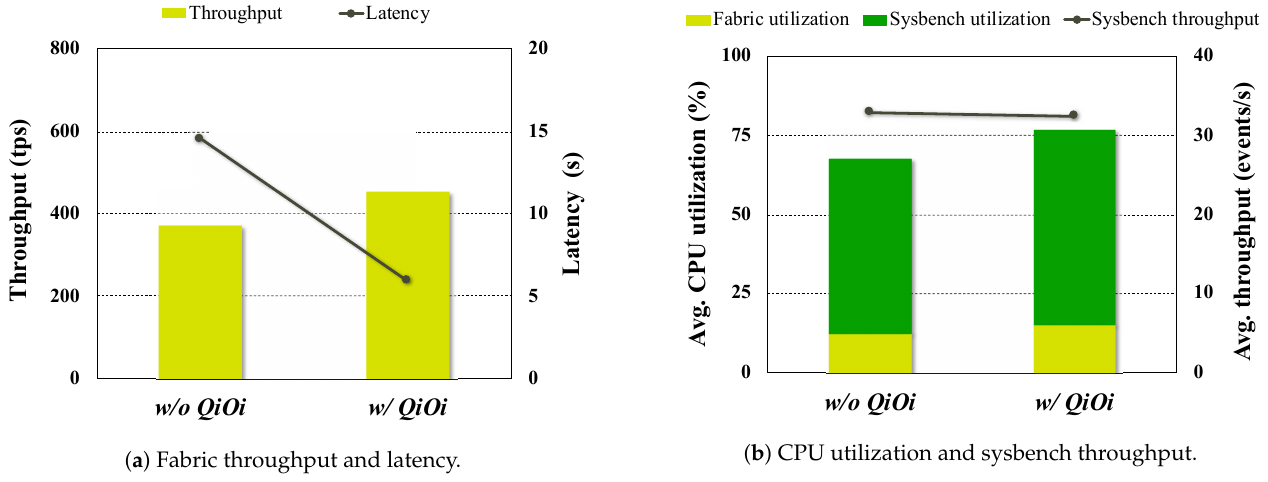
Figure 8. Impact of QiOi on Raft ordering service-based Fabric